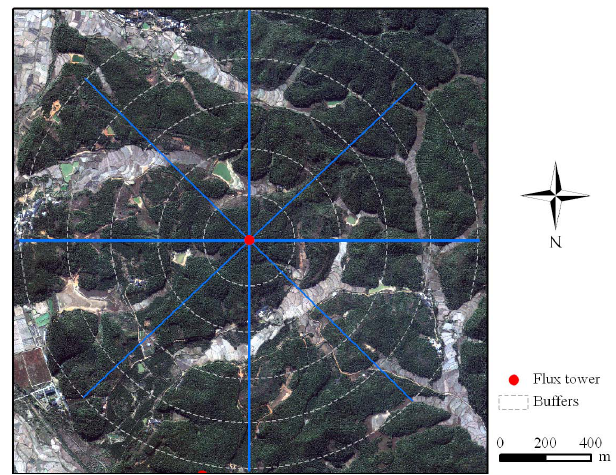
Fig. 1. The IKONOS image (Nov. 7, 2003) around the QYZ flux tower (red point). The interval between buffer circles is 200m.